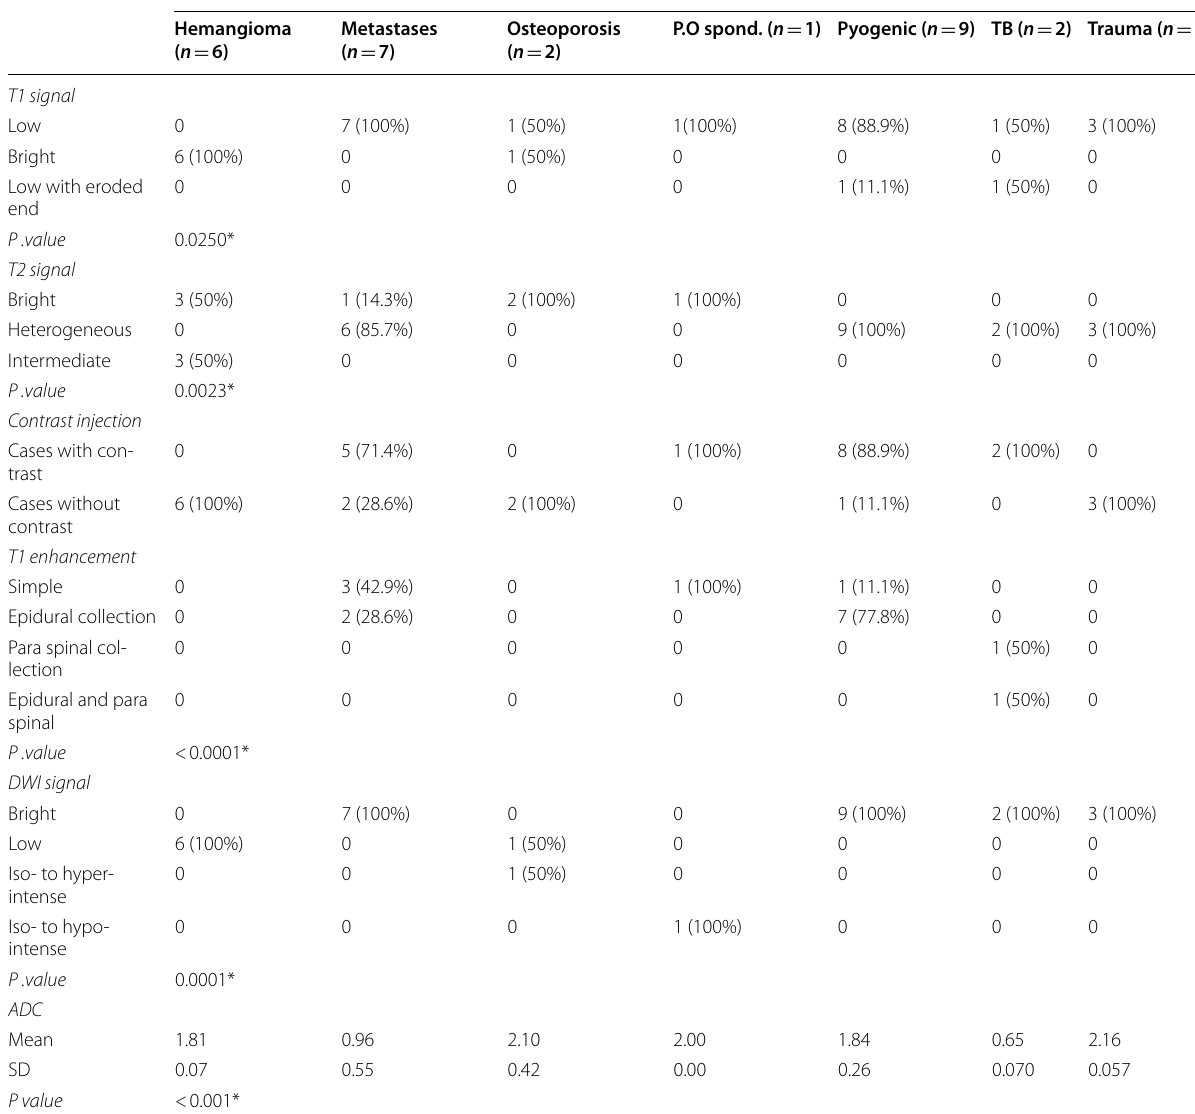
Table 2 MRI signals according to diagnosis in the study